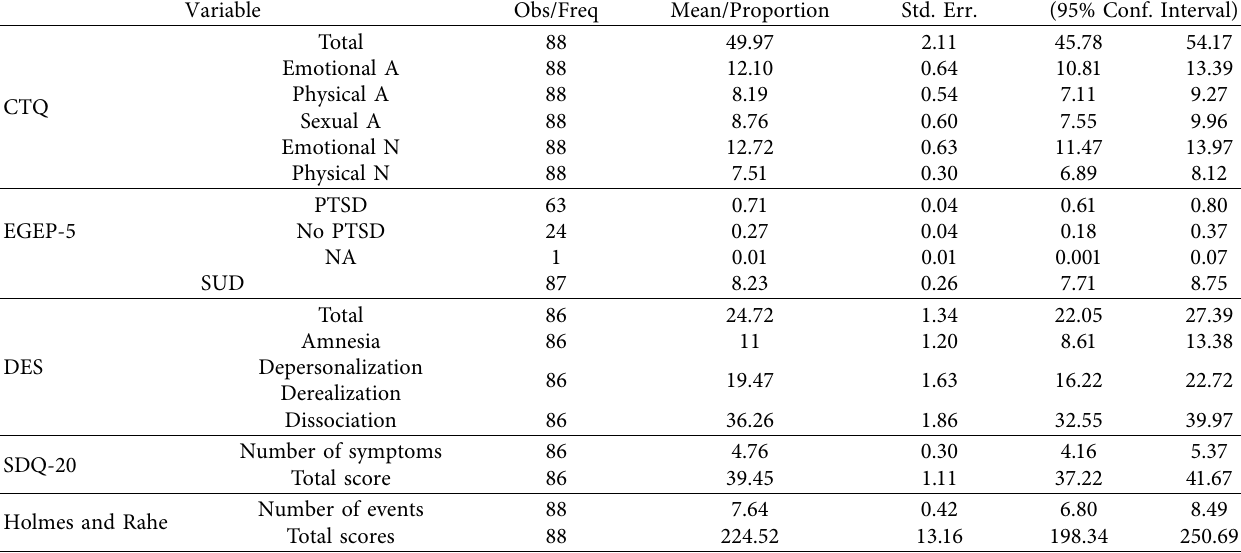
Table 3: Clinical variables of psychological trauma. Data are presented as the mean (SD). Variable